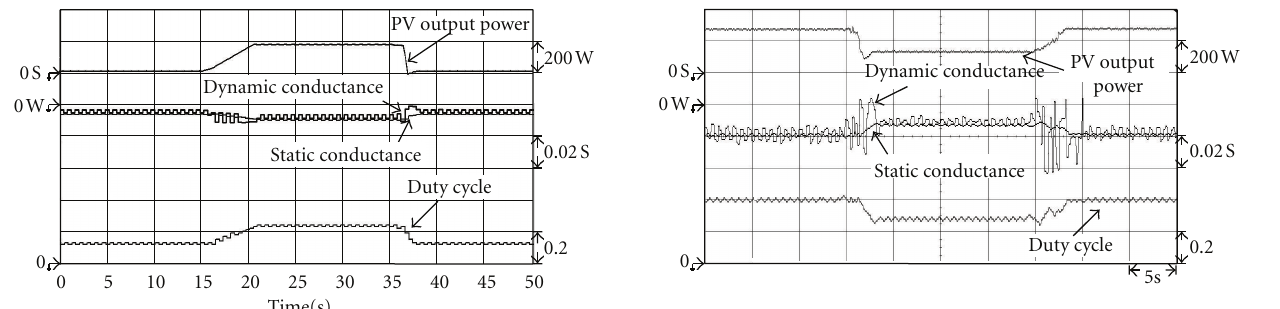
Figure 16: Measured output power, dynamic conductance, static conductance, and duty cycle waveforms of a PV module array using the variable step size INC method under irradiation that dropped from 1,000 W/m 2 to 700W/m 2 and then increased back up to 1,000 W/m 2 .